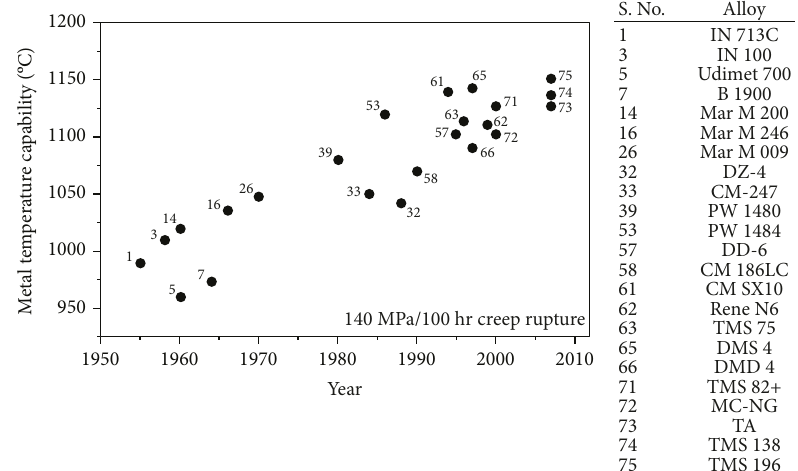
Figure 5: Improvement in temperature workability exhibited by development of newer generation superalloys